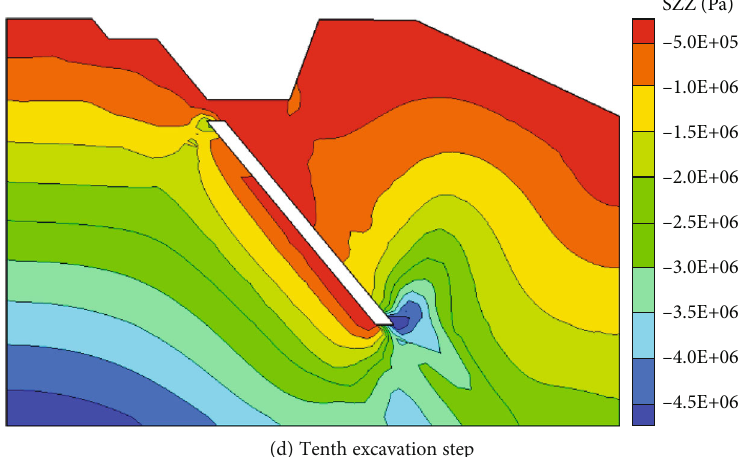
Figure 7: Stress distribution after underground excavation.